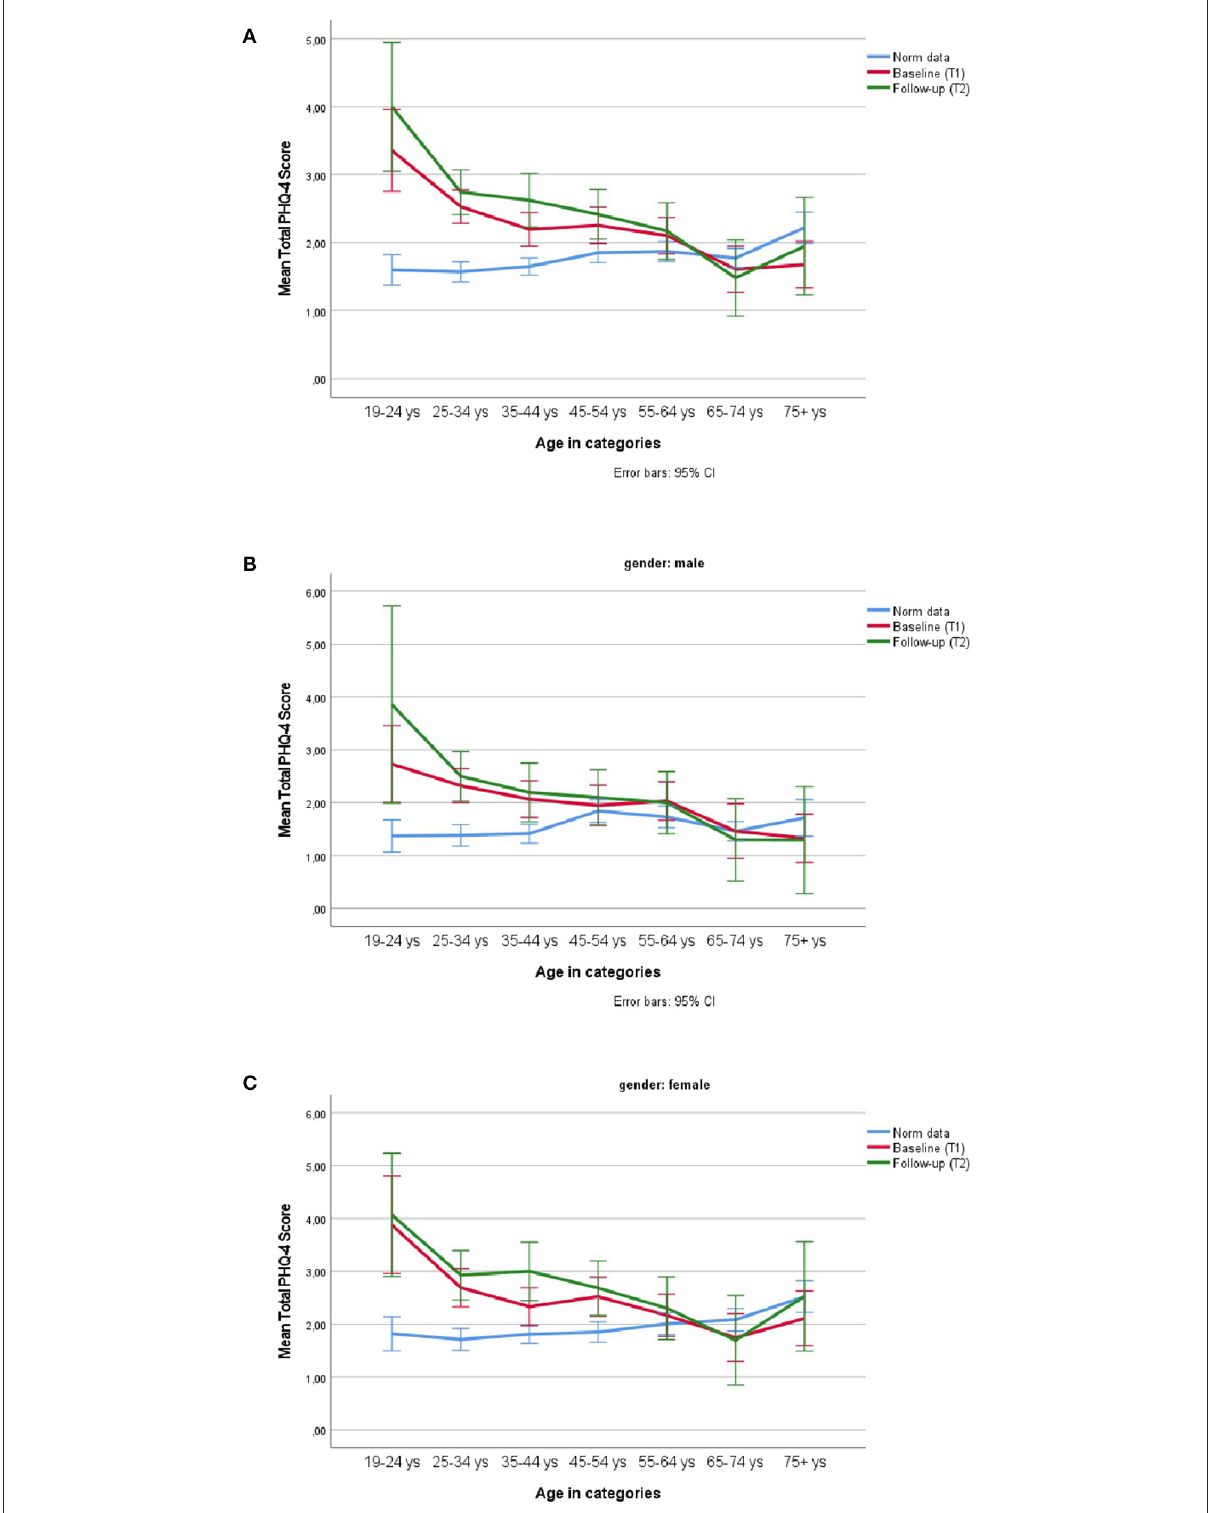
FIGURE1 PHQ-4 mean scores at T1 and T2 in the survey population as compared to PHQ-4 normative data in different age groups in (A) the total sample, (B) in males, and (C) in